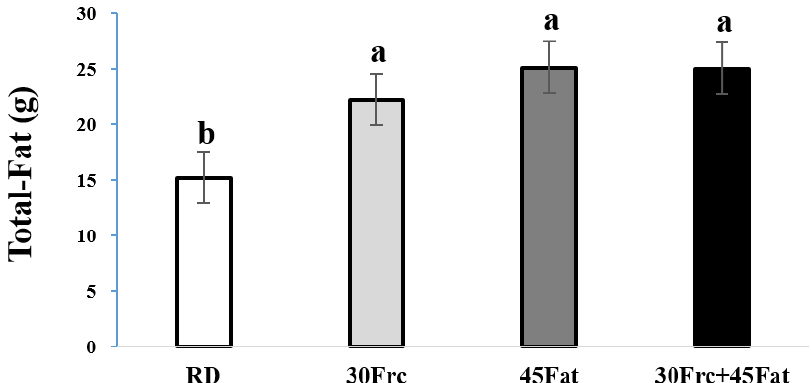
Figure 1. Total-fat weight in the experimental groups. RD: rats received a regular diet based on AIN-93G (4.0 kcal/g diet); 30Frc: rats received a 30% fructose-diet based on control-diet (4.0 kcal/g diet); 45Fat: rats a received 45 kcal% fat-diet (4.8 kcal/g diet); 30Frc + 45Fat: rats received a 45 kcal% fat-diet with 30% fructose (4.8 kcal/g diet). Statistical differences between the experimental groups were based on one-way ANOVA and Duncan’s multiple range tests at p < 0.05. Means with different alphabetical letters are significantly different ( p < 0.05).